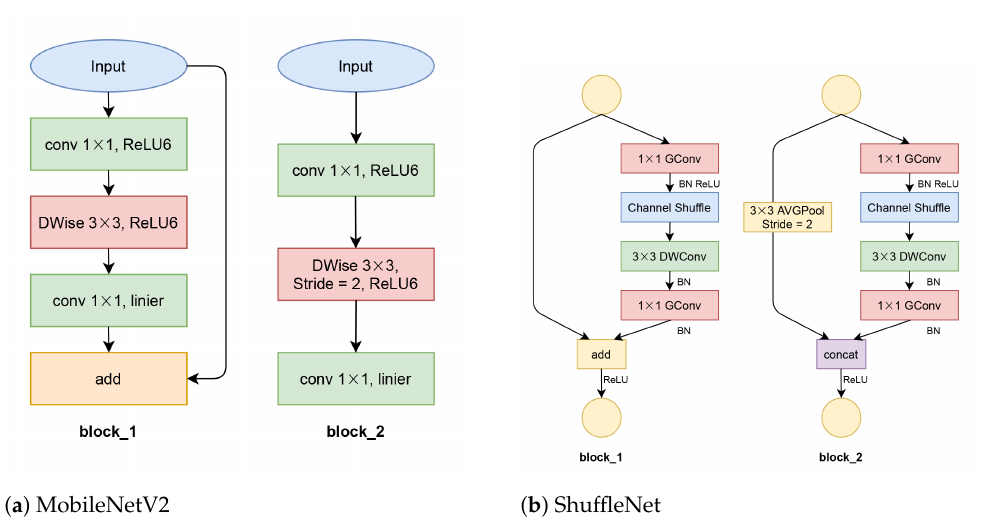
Figure 4. The basic architecture of MobileNetV2 and